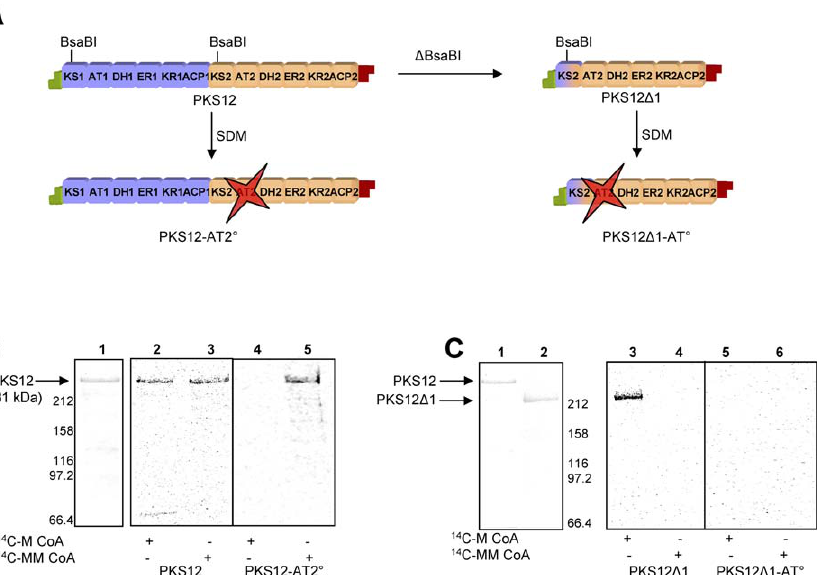
Figure 2. Determination of Specificities of the AT Domains and Construction of Single-Module PKS12 D 1 Protein (A) The PKS12 D 1 protein was constructed by deleting module 1 from the clone encoding PKS12 protein. The DNA encoding KS domains from module 1 and module 2 contains a conserved BsaBI restriction endonuclease site, which facilitated module 1 deletion. PKS12 D 1 retains N- and Cters of PKS12 protein. PKS12 AT2 null mutant (PKS12AT2 8 ) and PKS12 D 1 AT null mutant (PKS12 D AT 8 ), both mutated at the catalytic Ser residue were constructed by using standard SDM protocols. The mutations in the domains are marked in red. (B) Labeling of PKS12 protein with radioactive extender units. Lane 1 shows the Coomassie-stained, purified PKS12 protein (431 kDa). The protein could be labeled with both 14 C-MCoA (lane 2) and 14 C-MMCoA (lane 3). AT2 (S2672A) point mutant of PKS12 is labeled by 14 C-MMCoA (lane 5) and not by 14 C- MCoA (lane 4) depicting specificity of module 1 for MMCoA and module 2 for MCoA. (C) Labeling of PKS12 D 1 protein with radioactive extender units. Lanes 1 and 2 show the Coomassie-stained, purified PKS12 (431 kDa) and PKS12 D 1 protein (234 kDa). PKS12 D 1 protein could be radiolabeled with 14 C-MCoA (lane 3) but not with 14 C-MMCoA (lane 4). AT (S2672A) mutant protein of PKS12 D 1 does not incorporate any radioactive label (lanes 5 and